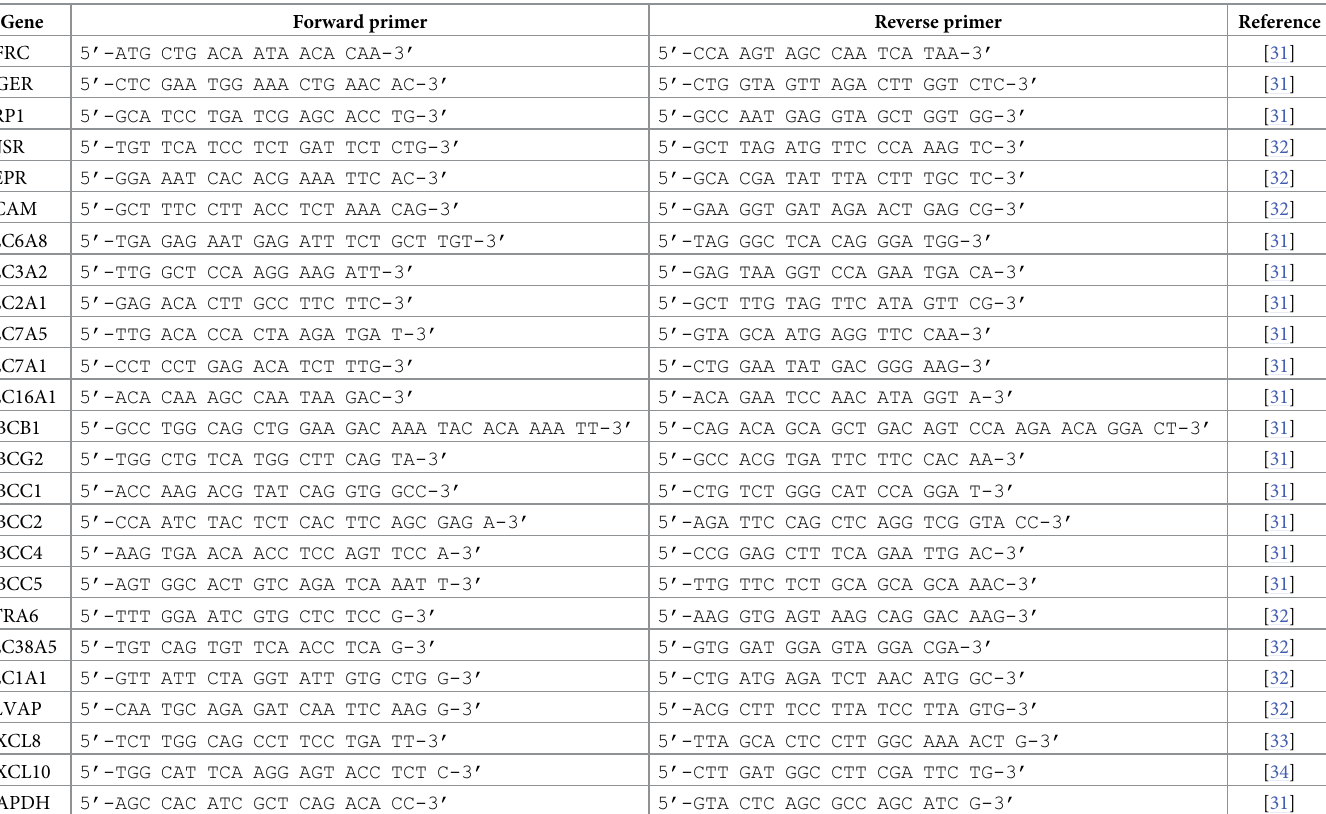
Table 1. Primers used for quantification of receptor, transporter and cytokine encoding